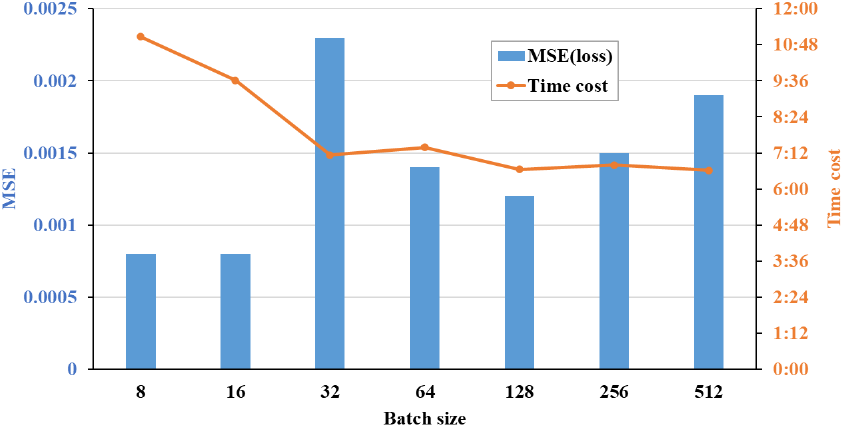
Figure 5. MSEs and time costs of different batch